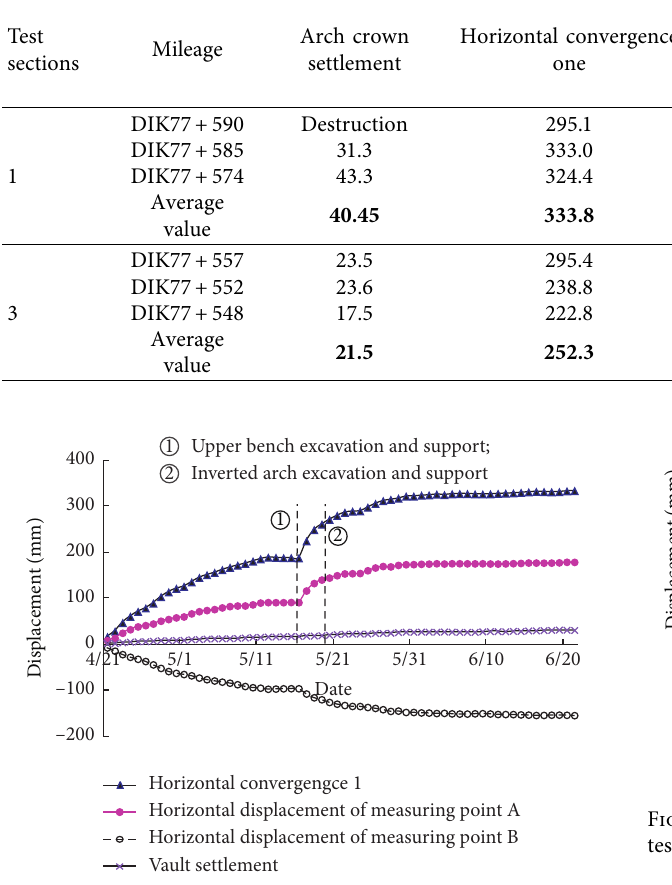
Figure 7: Time-history curves of tunnel deformation in the first test section (DIK77+ 585).